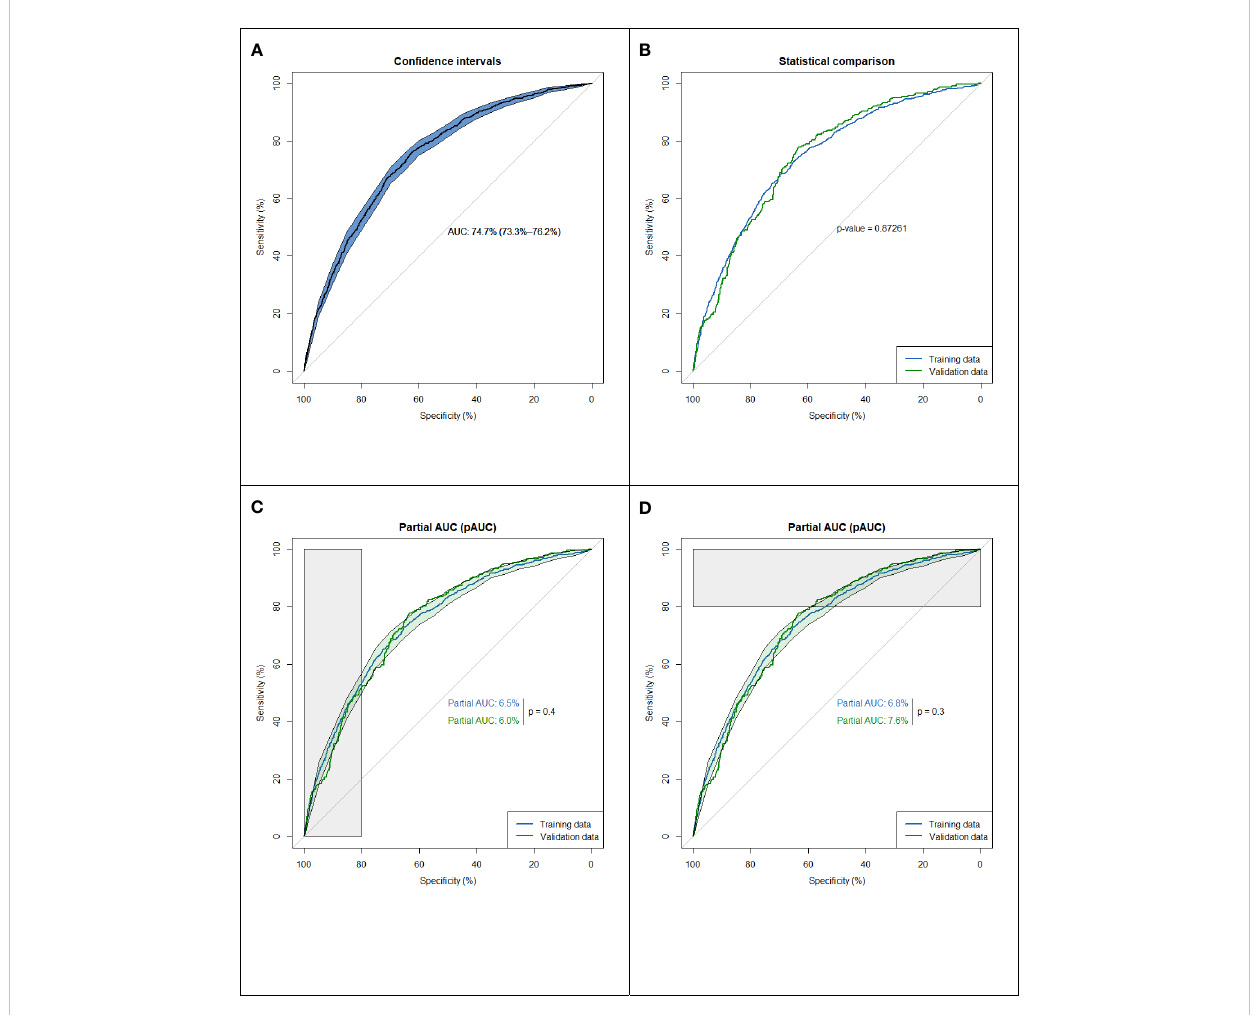
FIGURE 1 Assessing the discrimination of a fi tted logistic model, via the ROC curve. (A) Discriminatory performance of the full model (n=6295). (B) Comparison of ROC curves for the training data (n=5036) and the validation data (n=1259). (C) Average sensitivity, between 80%-100% speci fi city values. A little disparity (p=0.4) in the model's performance in prospective testing under high true negative rate. (D) Average speci fi city, between 80%-100% sensitivity values a little disparity (p=0.3) in the model's performance in prospective testing under ospective high true positive